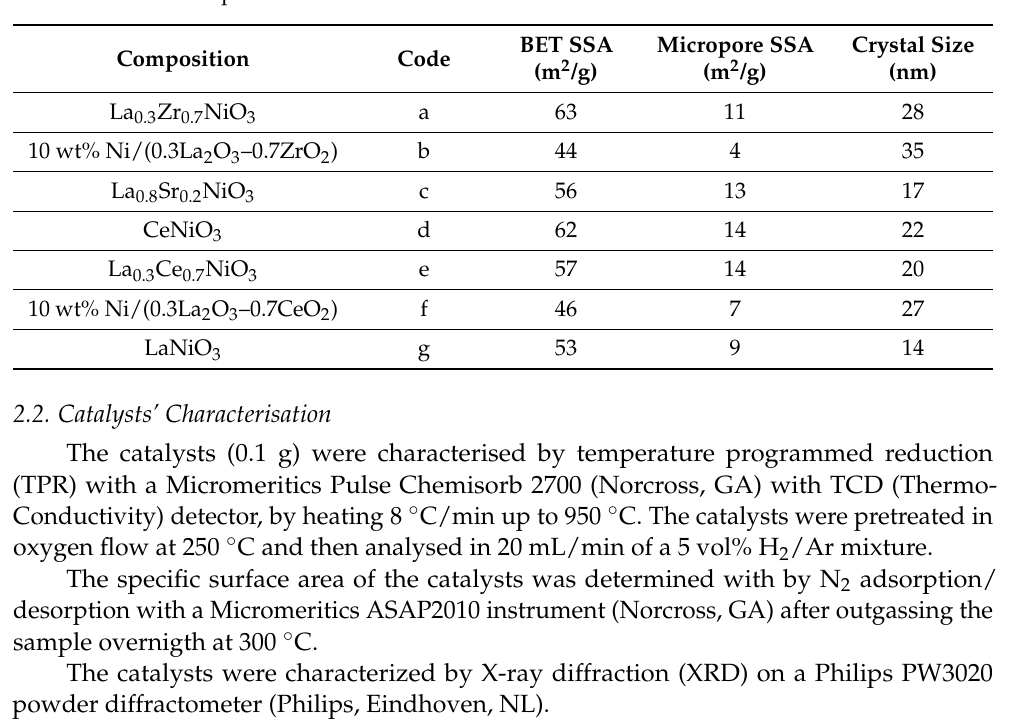
Table 1. Composition and textural properties of the catalysts prepared by flame spray pyrolysis (FP). SSA = specific surface area, evaluated through the Brunauer Emmet Teller model. Micropore SSA evaluated from the t-plot